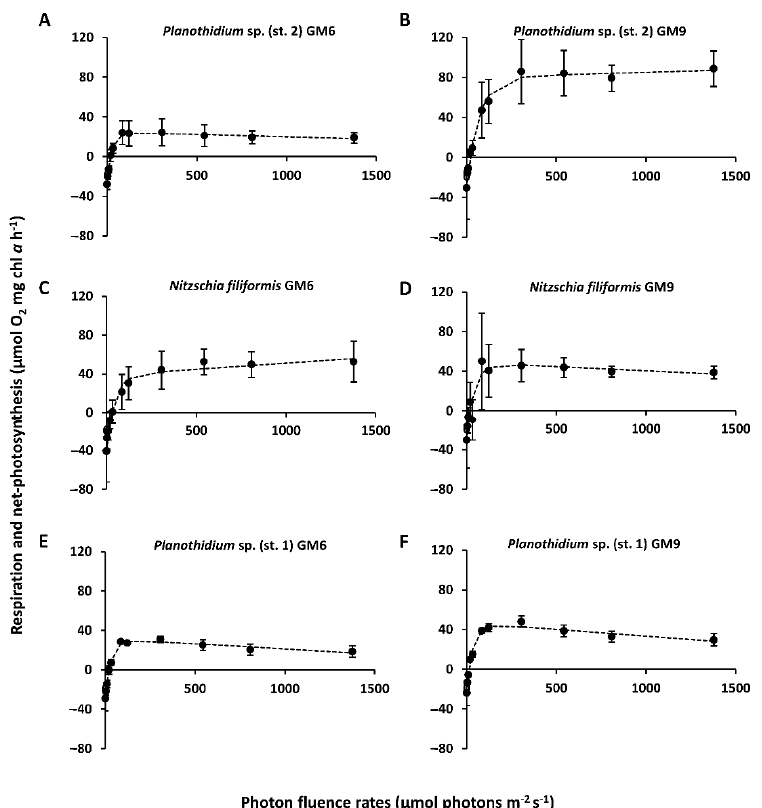
fitted by the model of Walsby [35]. Data points were